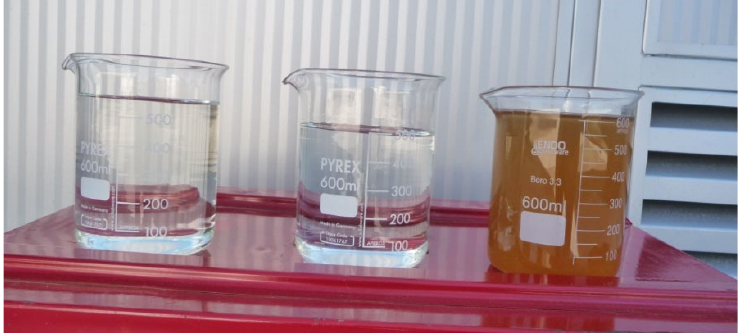
Figure 3. Feed, permeate, and reject water.